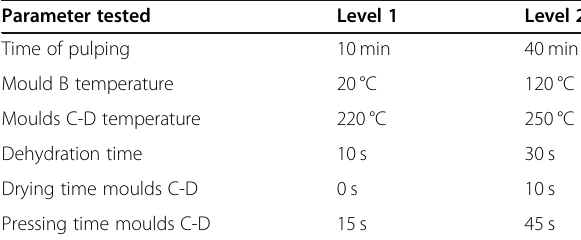
Table 1 Process parameters